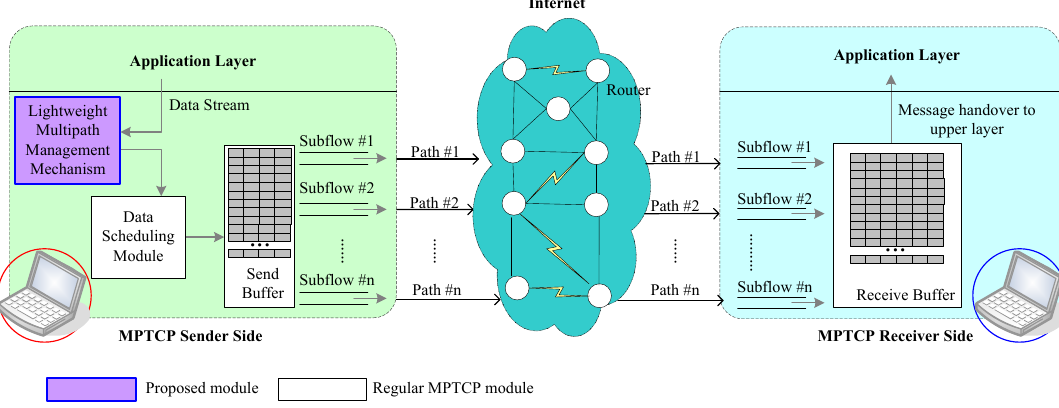
Figure 6. The architecture of MPTCP-Lightweight Multipath Management Mechanism (LM 3